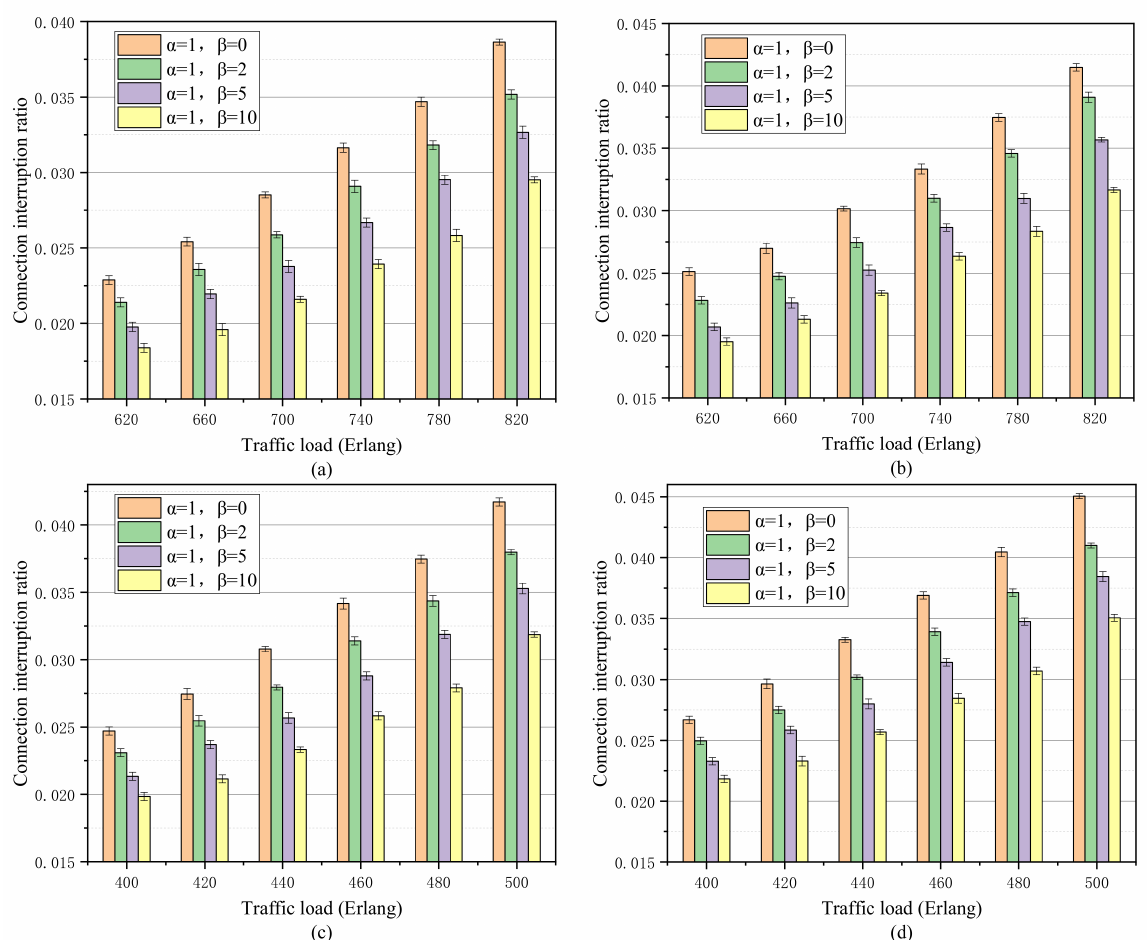
Figure 6. ( a ) CIR under uniform traffic model when 8 nodes are upgraded in USNET; ( b ) CIR under non-uniform traffic model when 8 nodes are upgraded in USNET; ( c ) CIR under uniform traffic model when 5 nodes are upgraded in NSFNET; ( d ) CIR under non-uniform traffic model when 5 nodes are upgraded in